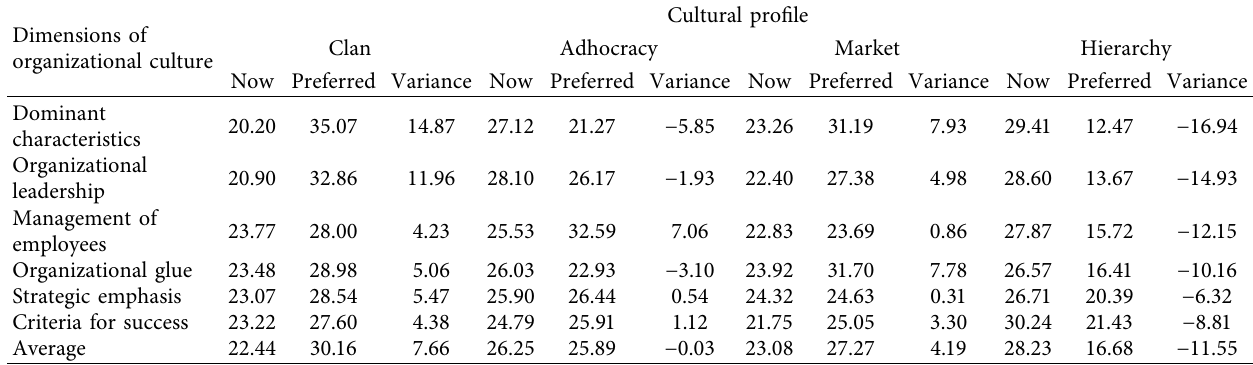
Table 6: Summary of mean cultural profile scores.